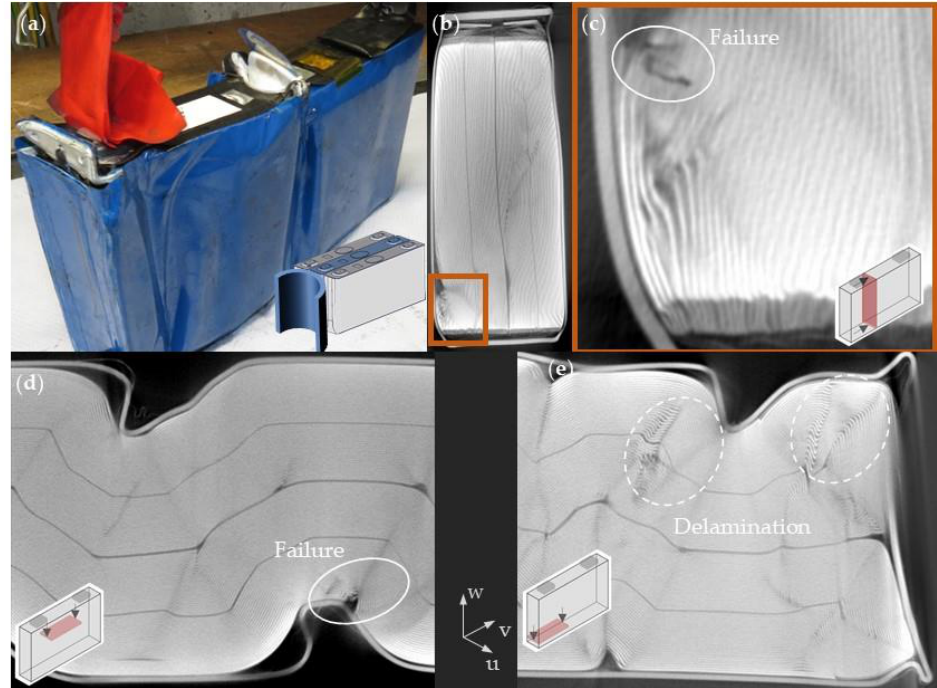
Figure 15. V-direction with cylindrical impactor: ( a ) deformed middle cell; ( b – e ) CT-Scans.